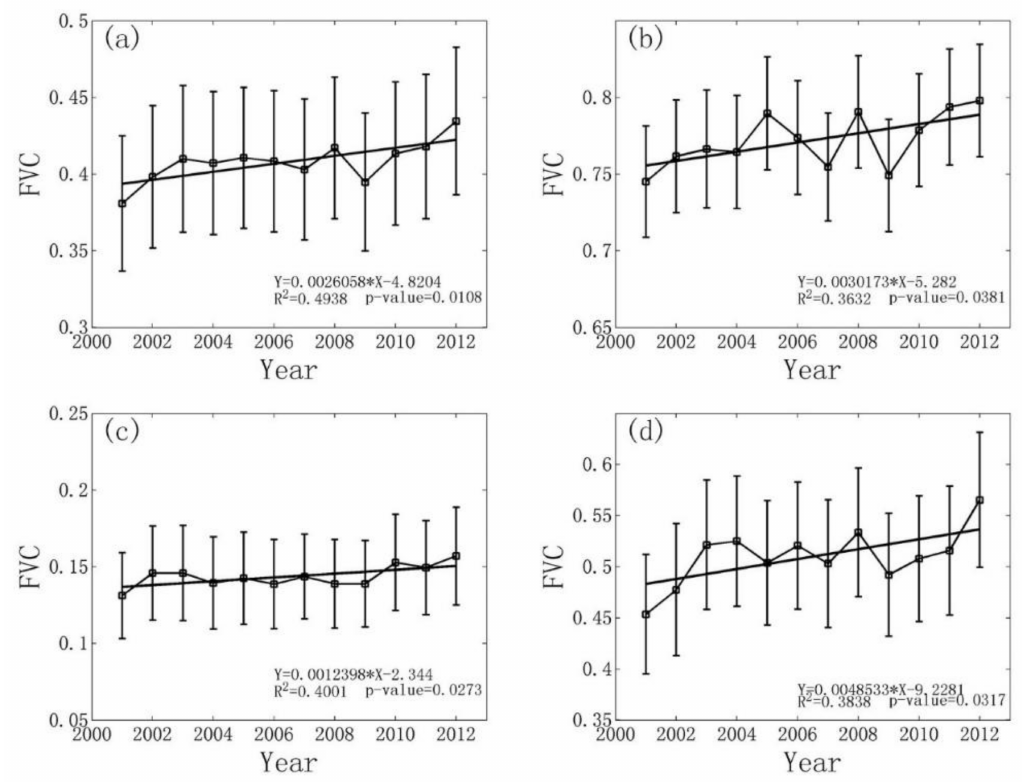
Figure 8. The averages of annual mean maximum FVC and trend in FVC with the error bars showing the standard error of multi-data set average. ( a ) northern China; ( b ) Northeast China; ( c ) Northwest China; ( d ) North